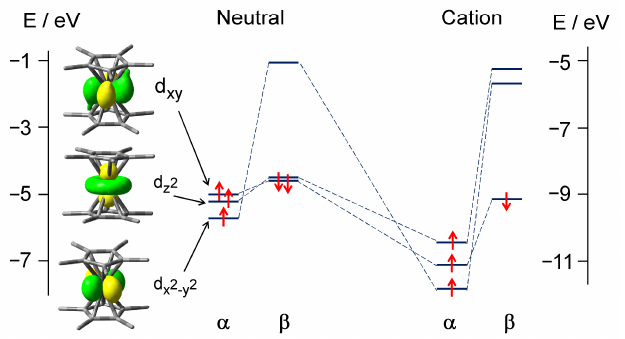
Figure 1. MO correlation diagram of the Cp* 2 Mn 0 neutral and Cp* 2 Mn + cation. The MO isosurfaces are given for the wavefunction value of 0.04. Notice the different energy scales for Cp* 2 Mn 0 (left) and Cp* 2 Mn + (right).